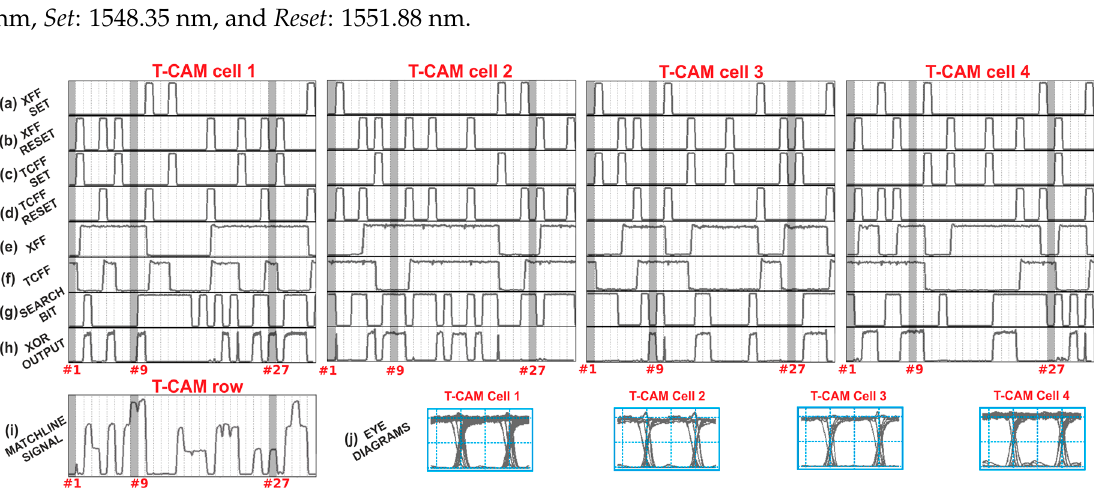
Figure 9. 10 Gbps simulation results for the T-CAM row architecture of Figure 8: ( a ) the XFF Set; ( b ) the XFF Reset; ( c ) the TCFF Set; ( d ) the TCFF Reset; ( e ) the XFF; ( f ) the TCFF; ( g ) the Search Bit;